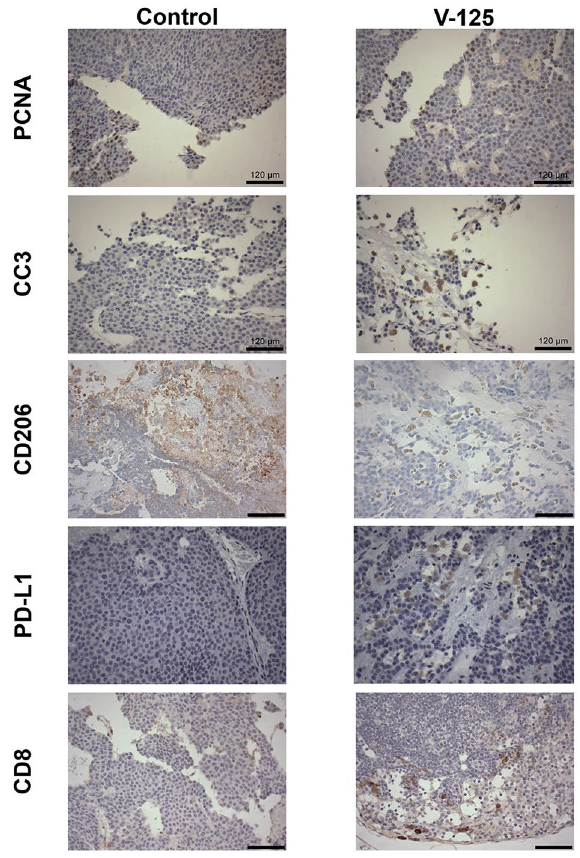
Figure 5. V-125 alters cell surface and intracellular markers in the MMTV-neu model of breast cancer. Mice with established mammary tumors 5 mm in diameter were treated with control or V-125 (100 mg/kg in diet) for 10 days. Immunohistochemical staining was performed for PCNA (proliferation), cleaved caspase-3 (CC3, apoptosis), CD206 (tumor-associated macrophages), PD-L1 (immune checkpoint), and CD8 (cytotoxic T cells) in the tumors. Scale bar represents 120